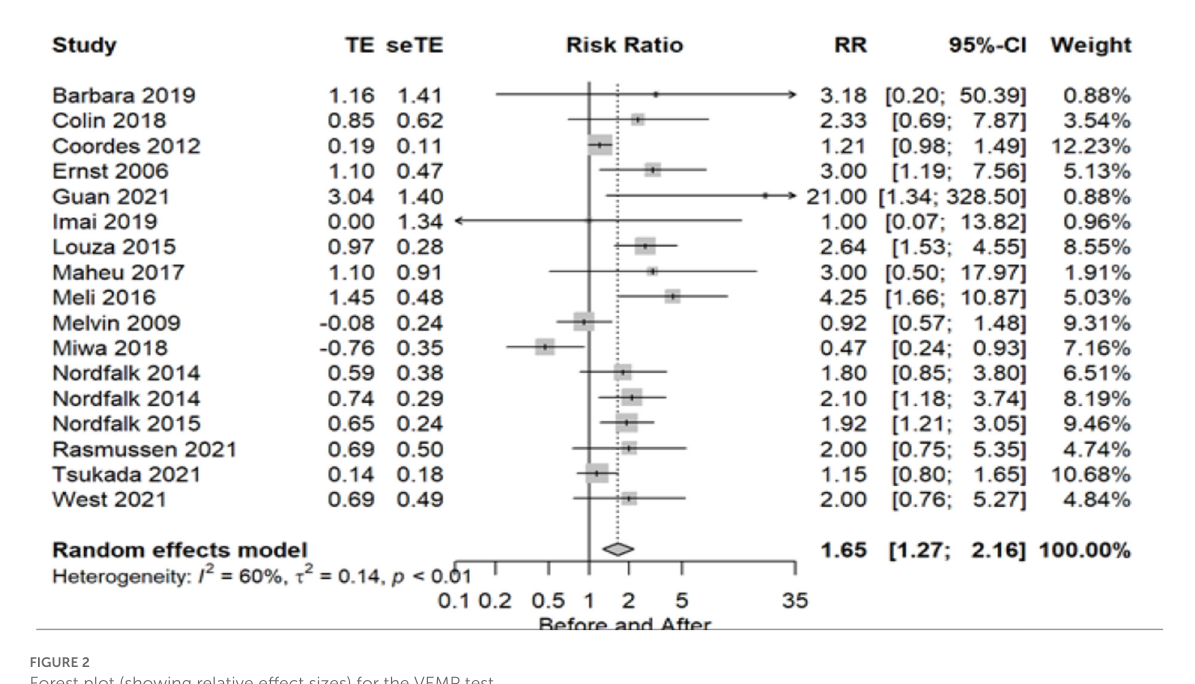
FIGURE2 Forest plot (showing relative effect sizes) for the VEMP test.